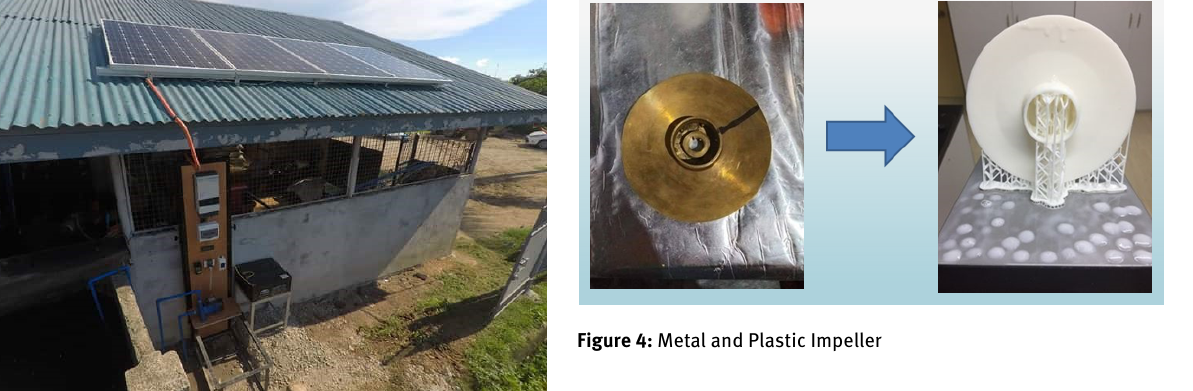
adopted farm is being watered three to four times a day for optimum harvest.